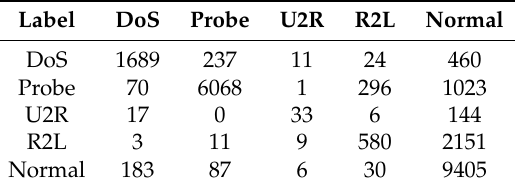
Table 11. Confusion matrix of ELM.